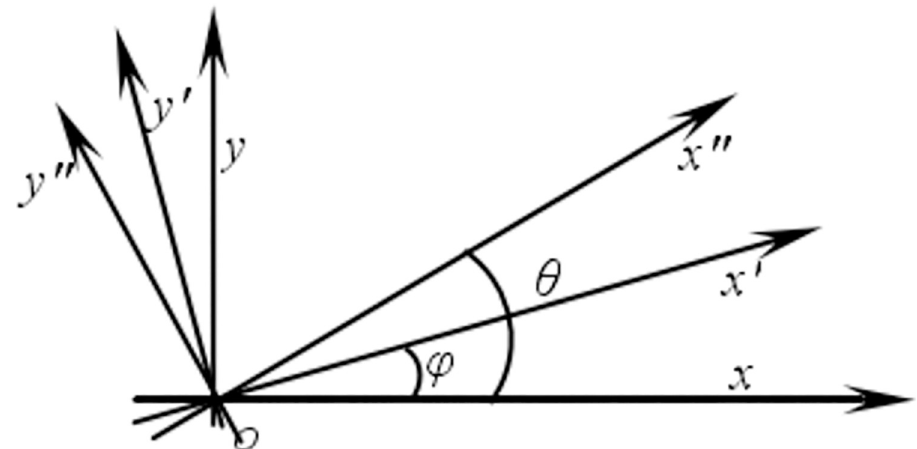
Fig 5. Shear strain representation of simple strain